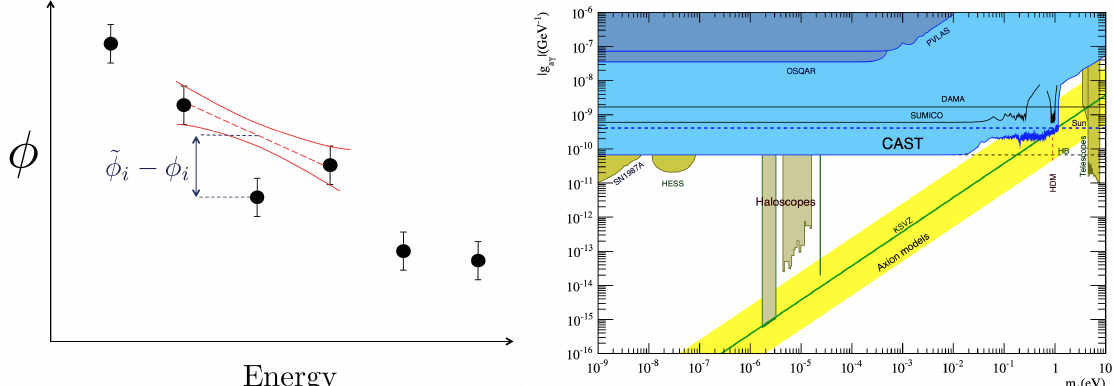
Figure 5. ( Left ) Schematic view of spectral irregularity quantification. Reprinted from Abramowski et al. [39]. ( Right ) Con- straints on ALPs parameter space set by CAST, compared with results from the previous helioscope Sumico and DAMA experiment, as well as with PVLAS [75] and OSQAR [17] experiments, constraints set by H.E.S.S collaboration, observations of SN1987A, Solar astrophysics and Dark Matter (DM) searches. Reprinted from Anastassopoulos et al.